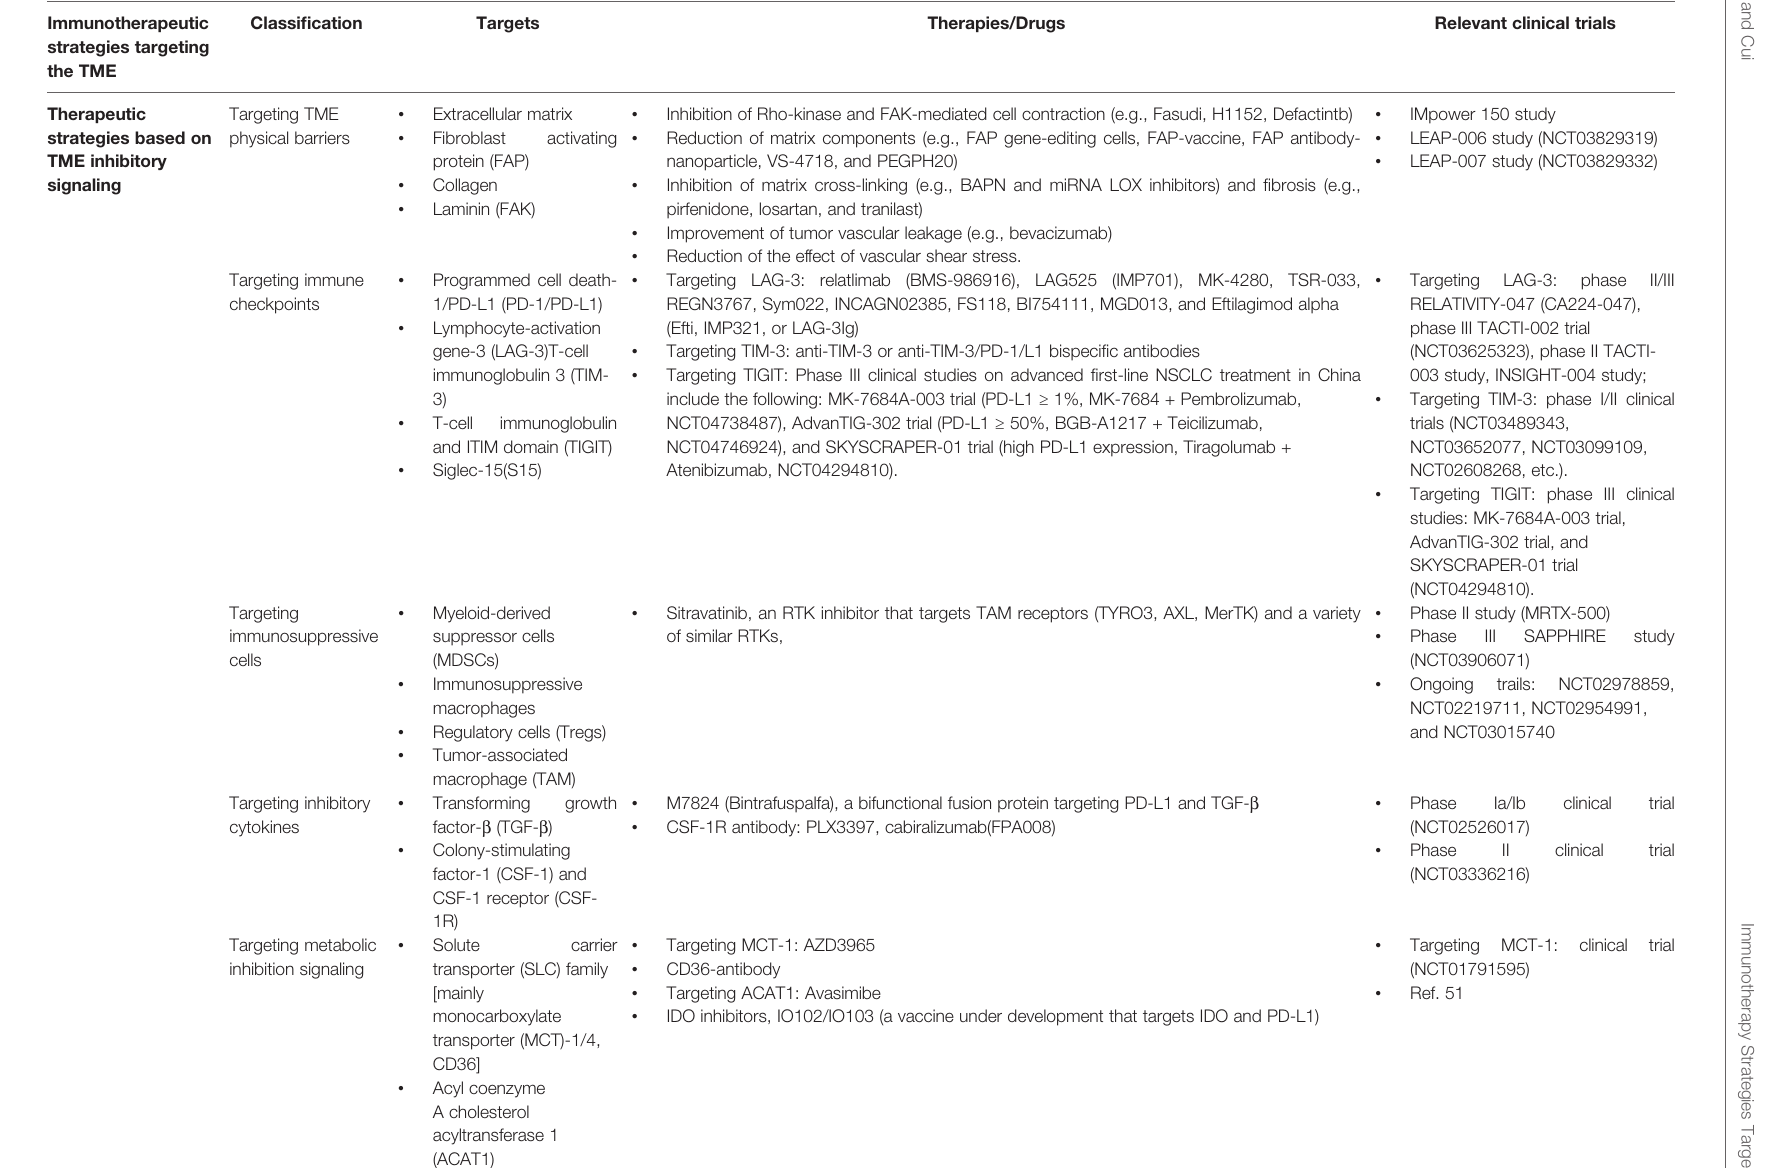
TABLE 1 | An overview of the current targets, therapies or drugs and related clinical trials of immunotherapeutic strategies targeting the tumor microenvironment (TME). Immunotherapeutic strategies targeting the TME Therapeutic strategies based